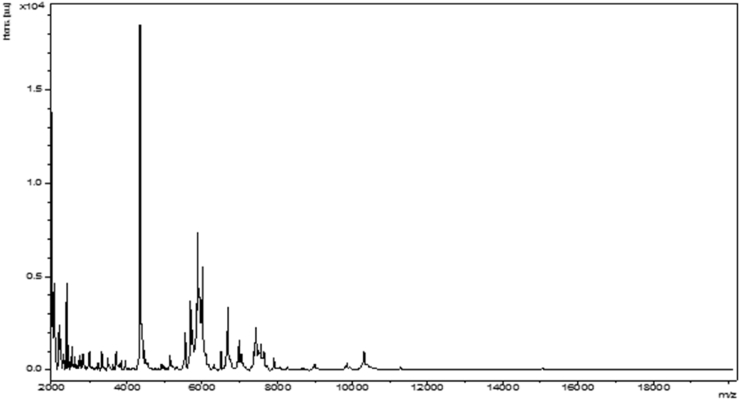
Reference mass spectrum from Senegalia massiliensis strain SIT17T.